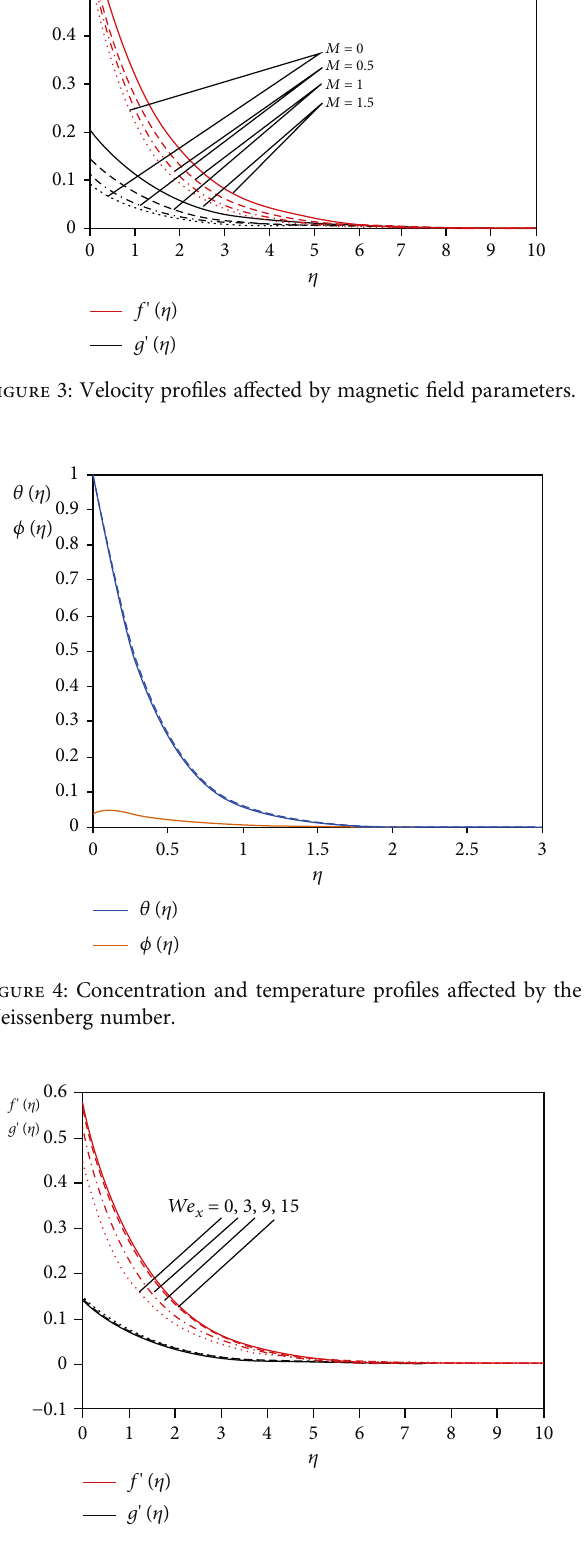
Figure 5: Velocity pro fi les a ff ected by the Weissenberg number.